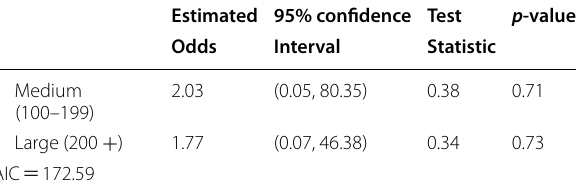
Table 7 Logistic regression model for active-learning cluster with 2-way interactions